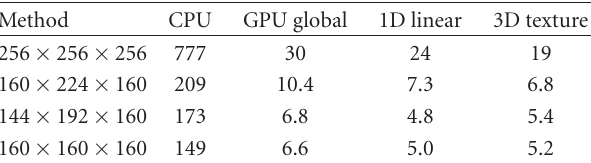
Table 3: Runtime comparison, in milliseconds, of di ff erent 3D interpolation implementations for reverse mapping operator with- out memory caching (GPU global), with linear texture cache (1D linear) and hardware accelerated interpolation using 3D texture. CPU reference and gives identical